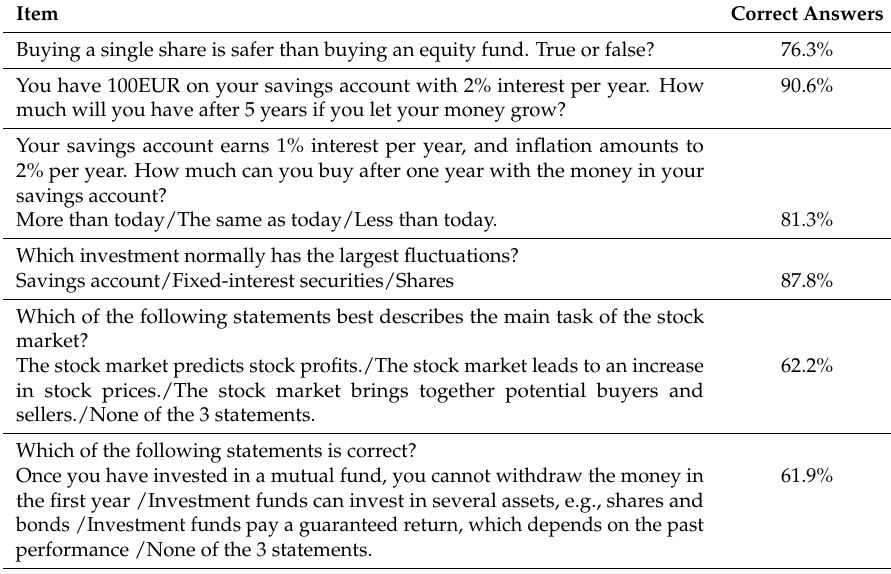
Table 8. The six items of the CL scale and the percentage of correct answers for these items.